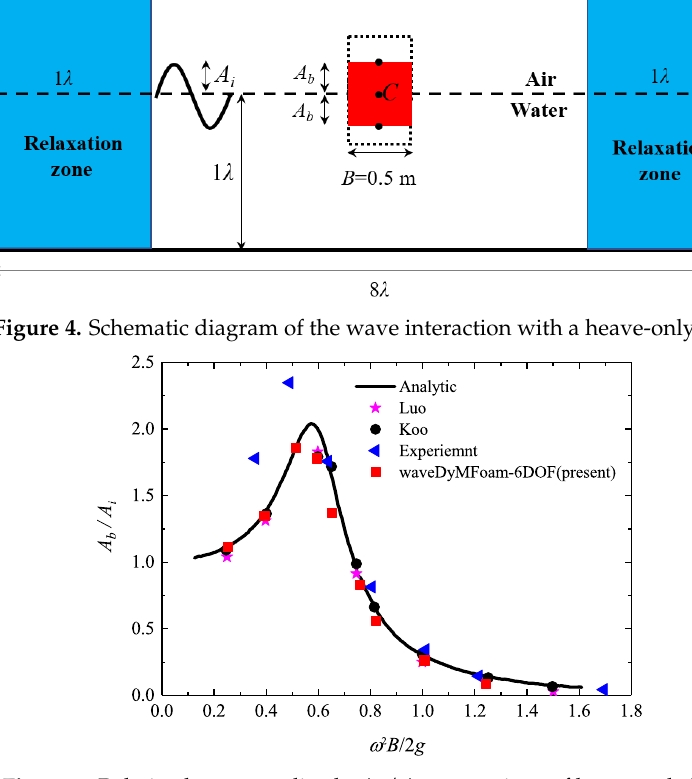
Figure 5. Relative heave amplitude A b / A i comparison of heave-only box.